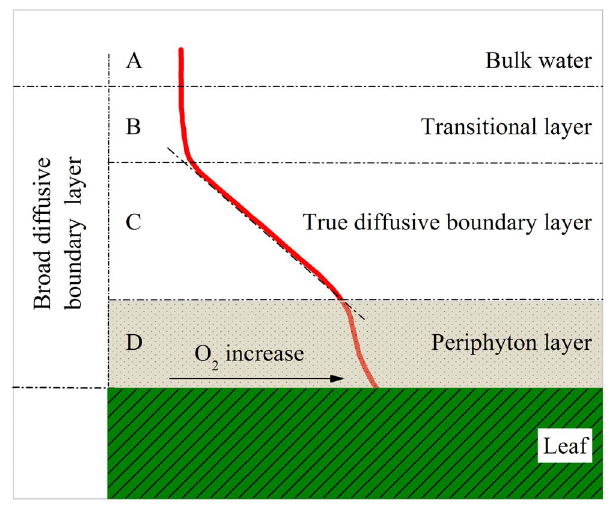
Figure 2. Schematic of oxygen microprofiles around sub- merged macrophyte leaves with periphyton.